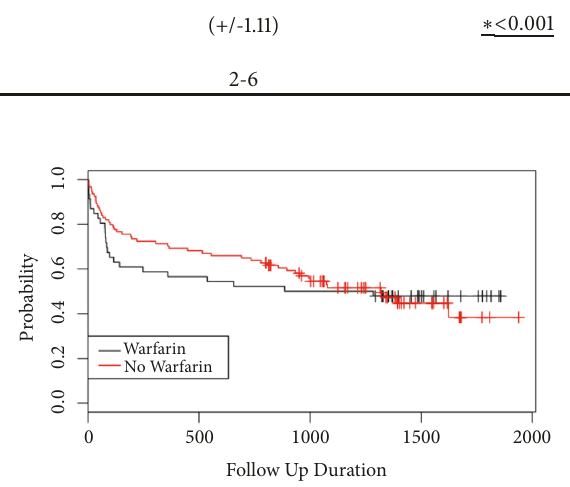
Figure 1: Kaplan-Meier curve of pre-guideline matched war- farinised and nonwarfarinised patients during 54-month follow-up (follow-up duration in